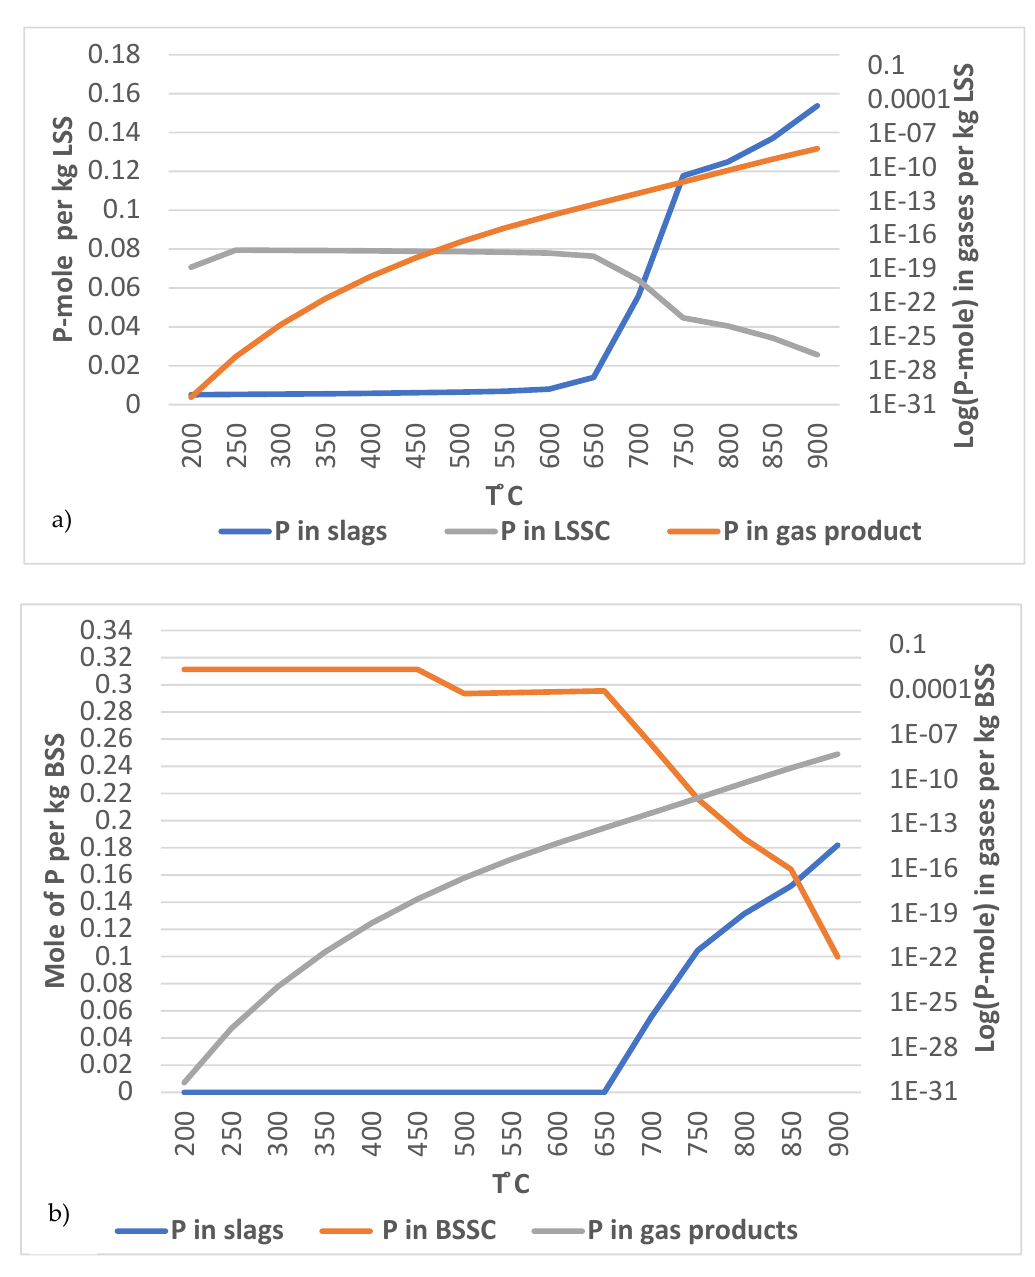
Figure 13. Distribution of P in the char, slags, and gaseous product during pyrolysis: ( a ) LSS and ( b ) BSS.